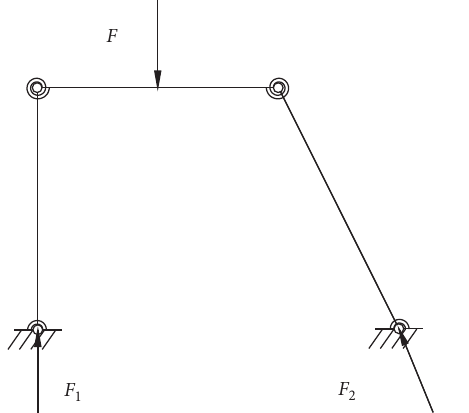
Figure 8: Explanation of the absence of the buckling load F frame with c R ≠ c L .